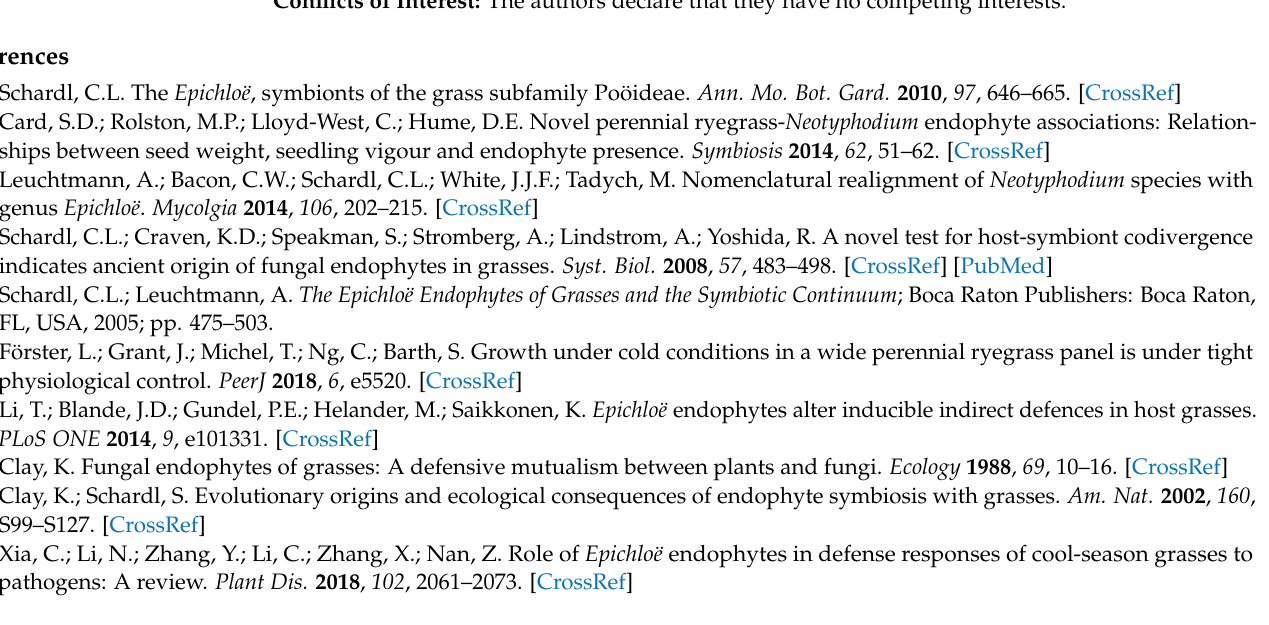
Table S1: BLAST hits of top 50 most abundantly expressed endophyte genes for SE, NEA11 and NEA12. Figure S2: Gene Ontology (GO) functional annotation of upregulated genes of SE at six time points of symbiotum establishment. Table S2: Enriched GO terms (Biological Processes) of the genes upregulated at different time points for SE, NEA11 and NEA12. Figure S3: Gene expression profiles of known alkaloid biosynthesis genes. Figure S4: Clustering analysis of DEGs during early stages of symbiotum establishment determined by Mfuzz for (A) SE, (B) NEA11 and (C) NEA12. Table S3: Top BLAST hits of genes identified as unique to SE from pairwise comparison of SE and NEA12. Table S4: Top BLAST hits of genes identified as unique to NEA11. Table S5: Top BLAST hits of genes identified as unique to